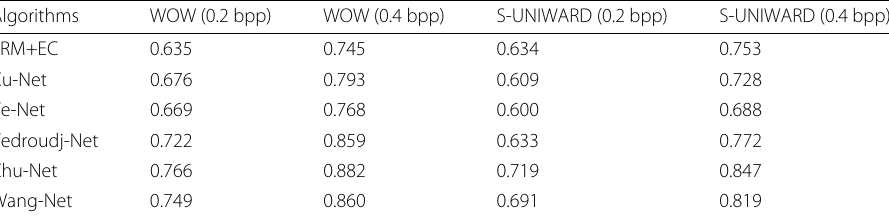
Table 5 The performance of Wang-Net and other steganalysis models on resampled images